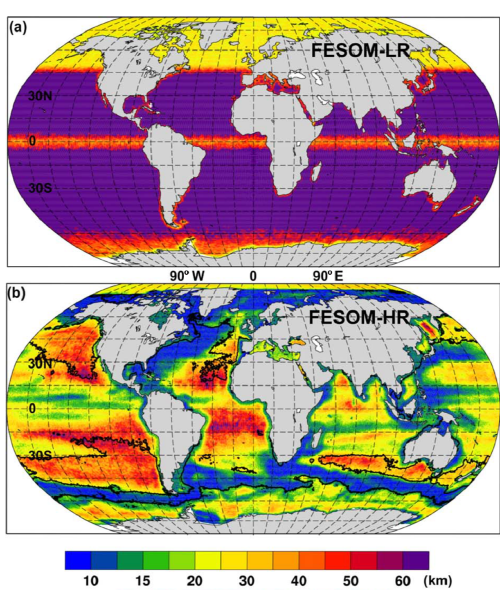
Figure 1. Horizontal resolution (km) of the two FESOM grids: (a) low resolution and (b) high